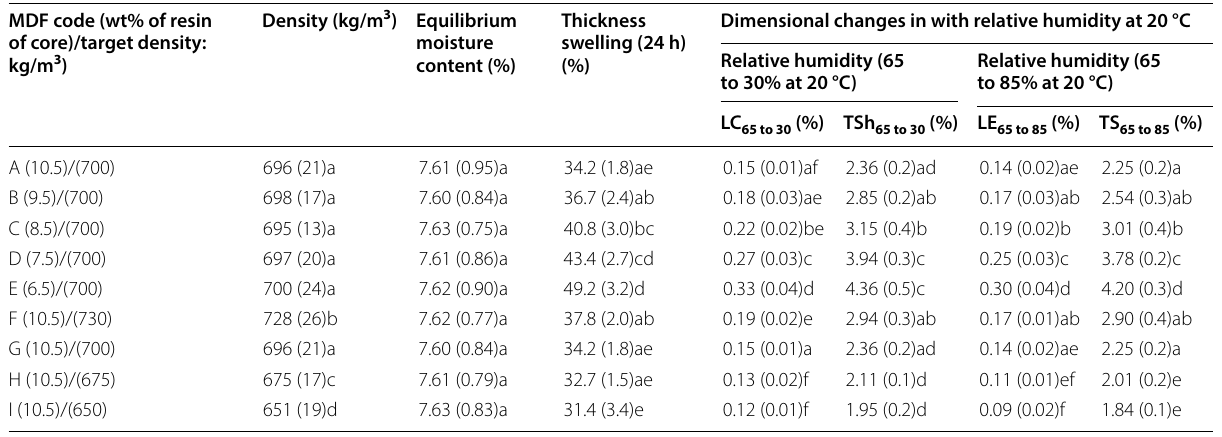
LC linear contraction, TSh thickness shrinkage, LE linear expansion, TS thickness swelling The values in the parentheses are standard deviations. Groups with same letters (from a to f) in each column indicate no significant statistical difference ( p < 0.05) between the specimens in the group according to Duncan’s multiply range test